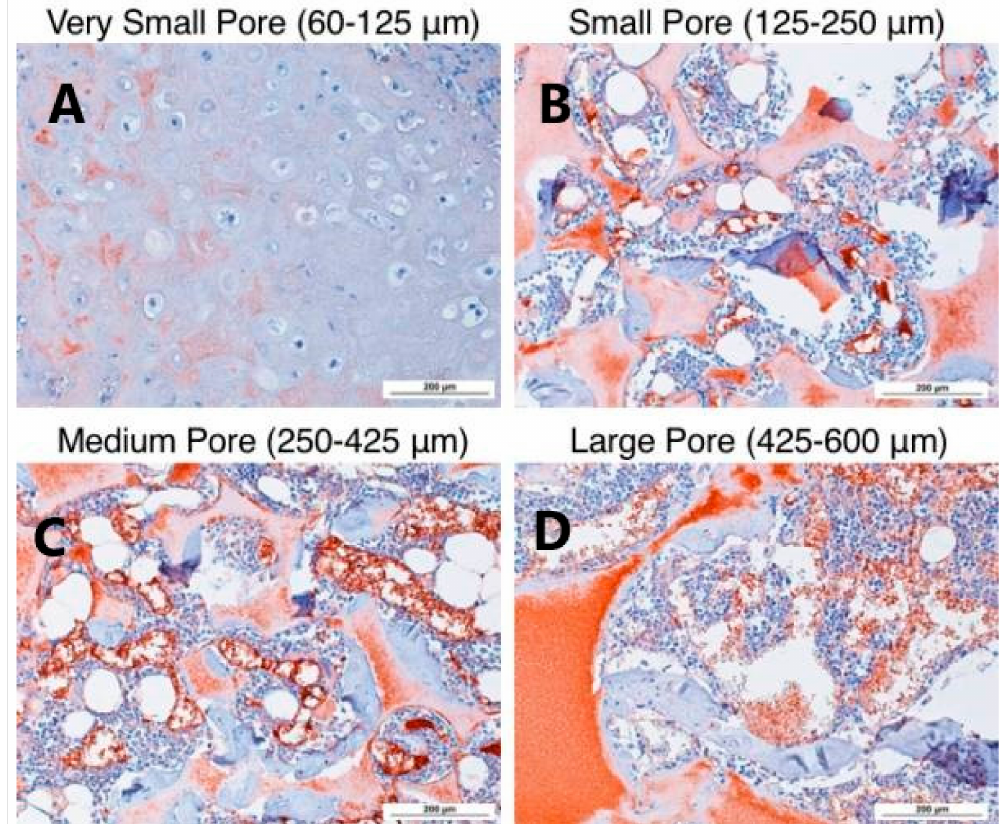
Figure 12. H&E histological analysis after 8 weeks of subcutaneous implantation at 100 × magnifica- tion. Small pore scaffold (60–125 µ m) ( A ) contained cartilage with typical morphology in the center of the scaffold. Small (125–250 µ m), ( B ) medium (250–425 µ m), ( C ) large-pore (425–600 µ m), and ( D ) scaffold-supported bone formation on pore walls, shown by pink staining of bone matrix, with bone-marrow-like tissue within the pores. N = 3 for each group. Scale bars = 200 µ m. Reprinted with permission from Acta Materialia Inc.